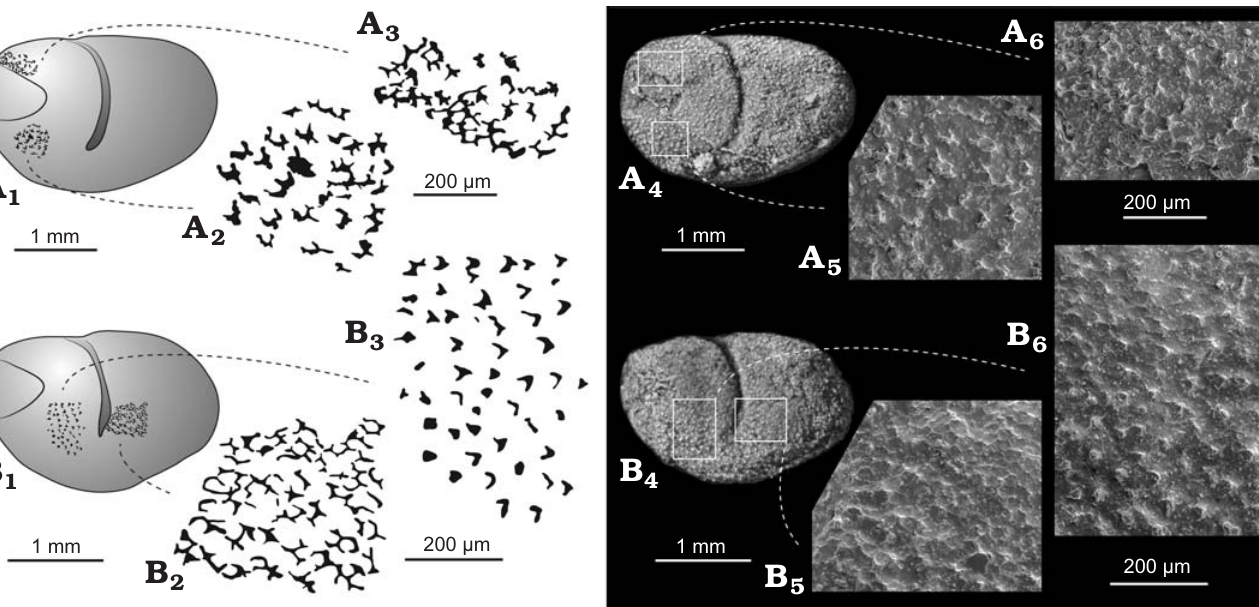
Fig. 6. Myodocope ostracod Nudator elegantulus sp. nov., details of the ornament, Holy Cross Mountains, Poland; Ludlow Series, Silurian. A . Holotype ZPAL O.63/15. Left valve (A 1 ): detail of the ornament anterodorsally (A 3 , A 6 ); detail of the ornament anteroventrally (A 2 , A 5 ). B . ZPAL O.63/13. Left valve (B 1 ): detail of the ornament anteriorly (B 3 , B 6 ); detail of the ornament posterior to the adductorial sulcus (B 2 , B 5 ). A 4 , B 4 , light photographs; A 5 , A 6 , B 5 , B 6 , SEM photographs; A 1 –A 3 , B 1 –B 3 , explanatory drawings; all lateral views of silicone casts of external